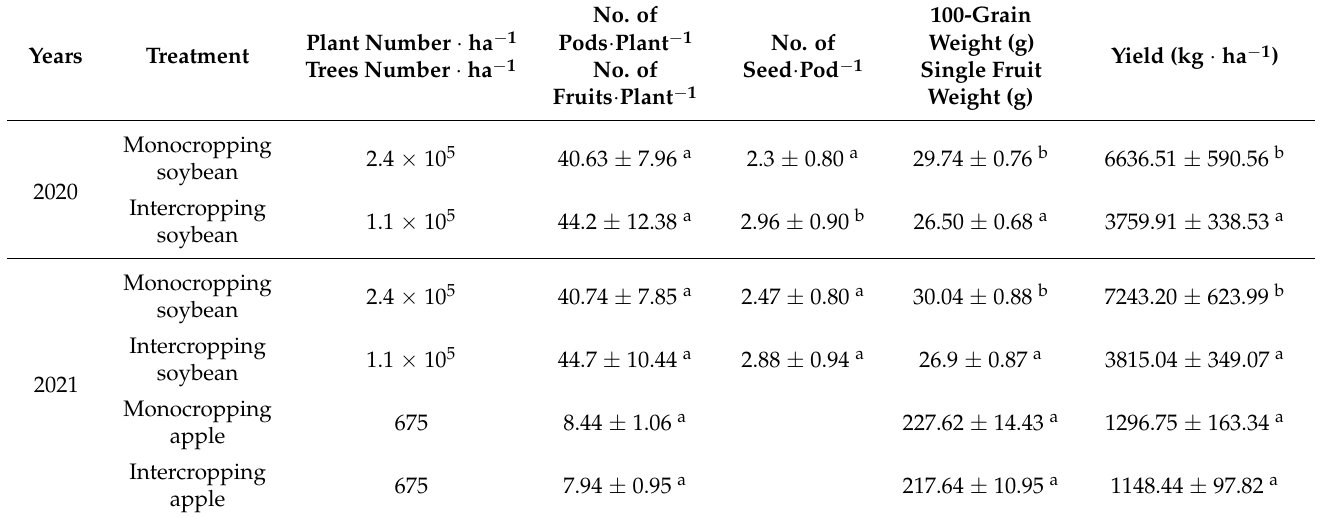
Table 3. Soybean and apple yield and yield composition factors under different planting patterns in 2020 and